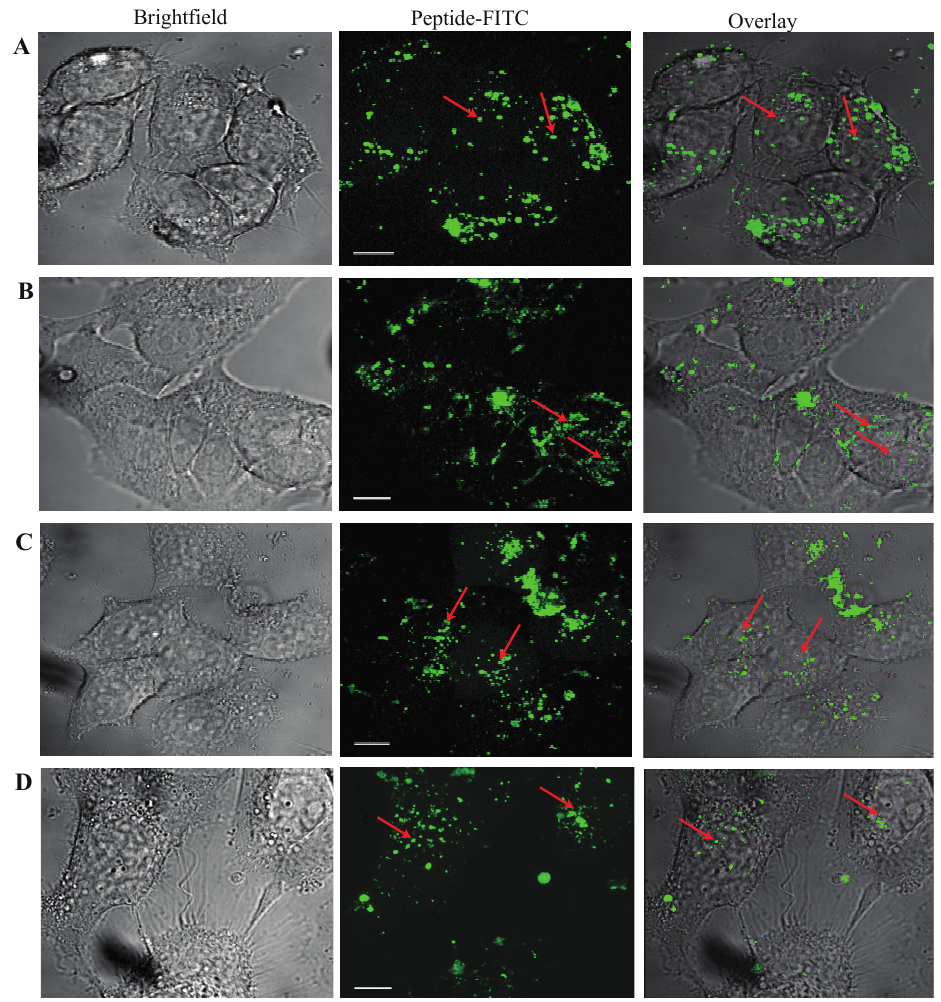
Figure 2. Cellular distribution of SRC-1 bioportides. ( A ) TP10-SRC1 ; LXXLL ( B ) TP10-SRC1 ; ( C ) R -SRC1 ; ( D ) R -SRC1 . Confocal microscopy 1222–1245 7 LXXLL 7 1222–1245 of MCF-7 cells exposed to 5 µM FITC-labeled peptides for 1 h. The cells were washed 3 times with stimulation medium before confocal microscopy of live cells was carried out. Nuclear localization of peptides is indicated with red arrows (63× magnification; scale bar 10 µm). Brightfield Peptide-FITC